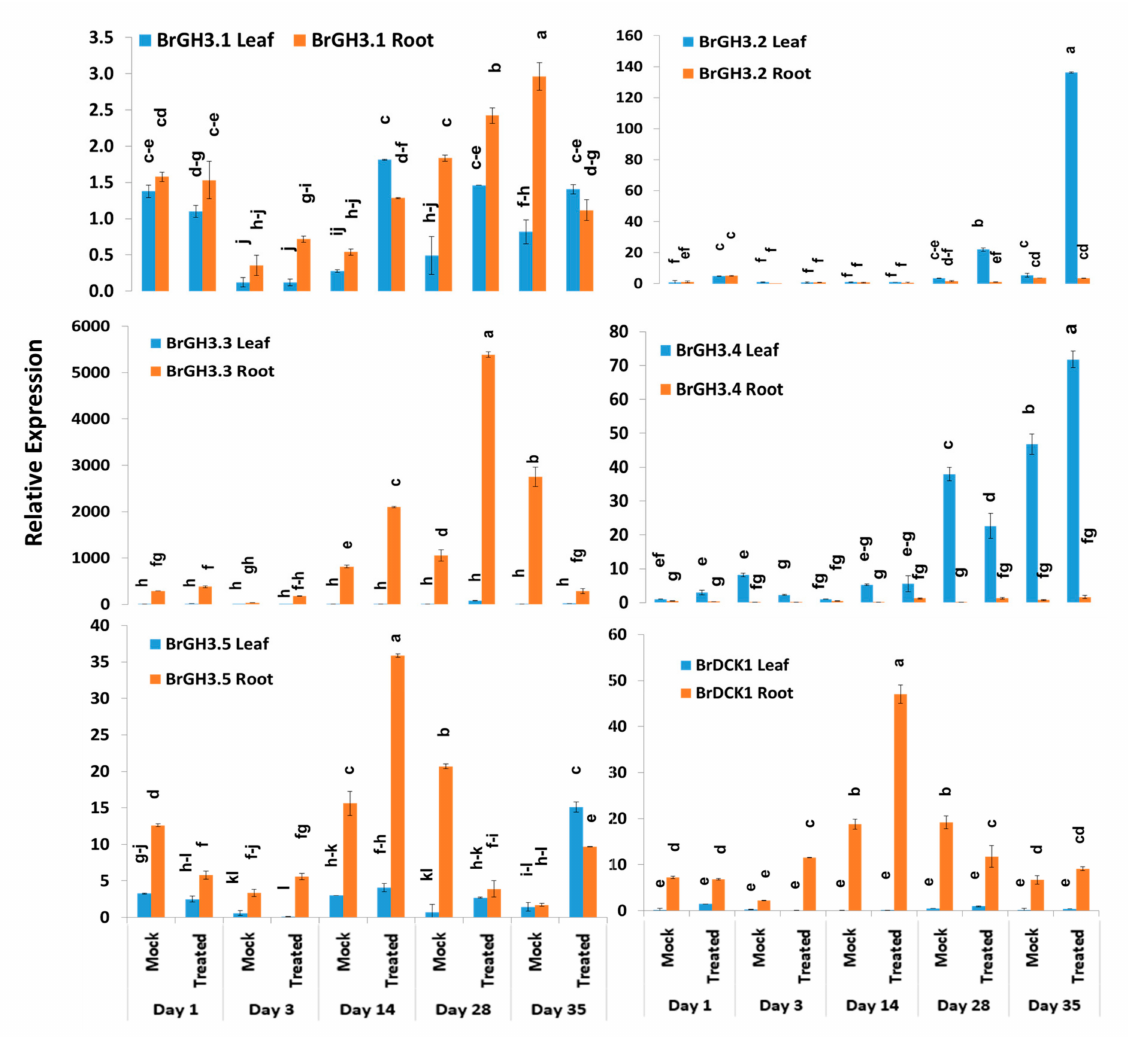
Figure3. Variationinrelativeexpressionlevelsof BrGH3 and BrDCK1 auxin-relatedgenesinleafandroot samples under di ff erent treatment × time-point combinations in mock-treated and Seosan-inoculated plants: Data represent relative expression levels of three di ff erent treatment types—sample type (leaf vs. root), treatment (Seosan-inoculated vs. mock-treated), and time-points. Vertical bars represent standard deviation. Each data point estimates the average of three independent biological replicates. Data bars separated by di ff erent letters indicate 5% statistical significance level according to Tukey’s pairwise comparisons. Expression of genes in leaf tissues of control (nontreated) plants on day 0 were set to